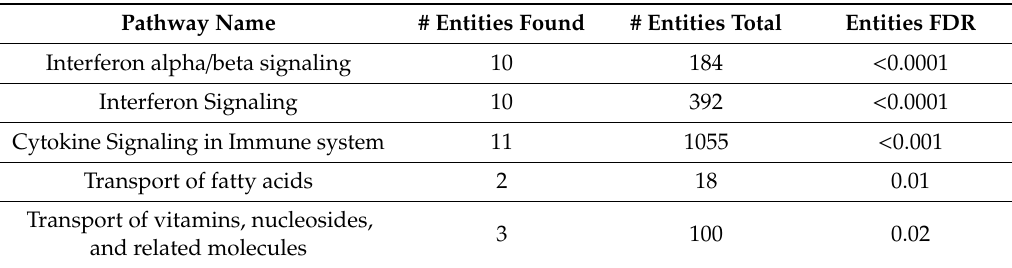
Table 2. Enriched pathways based on upregulated genes in E6 / E7 F57A cells (compared to pLXSN E6 / E7 cells).